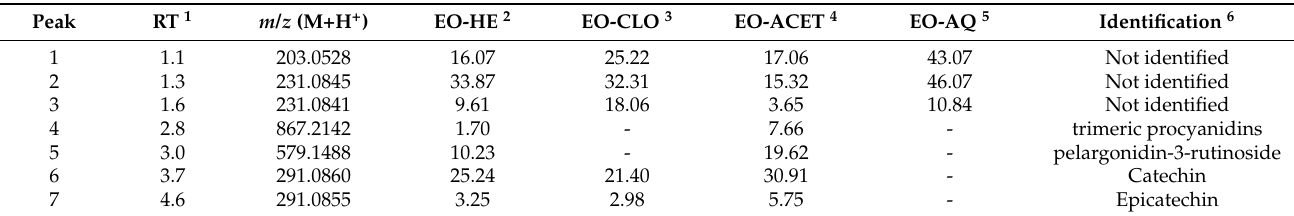
1 Retention time. 2 E. oleracea hydroalcoholic extract. 3 E. oleracea chloroformic fraction. 4 E. oleracea ethyl acetate fraction. 5 E. oleracea aqueous fraction. 6 Tentative